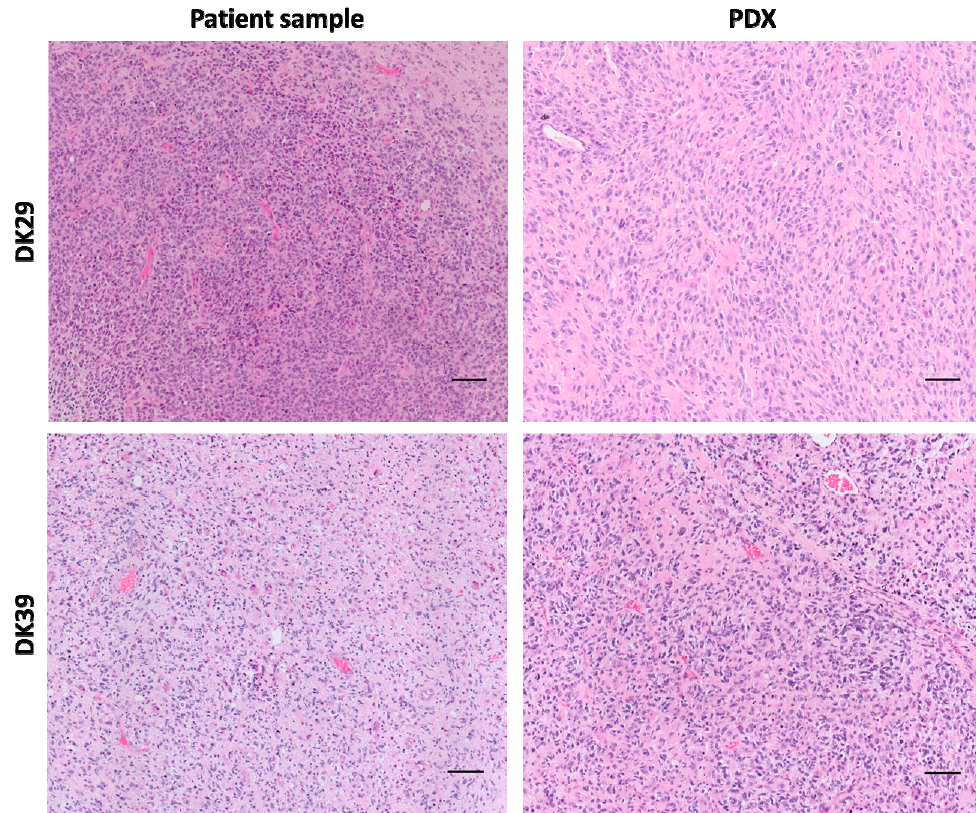
Figure 5. Hematoxylin and eosin stainings of the patient sample and the corresponding PDX. Scale bar = 100 µm.